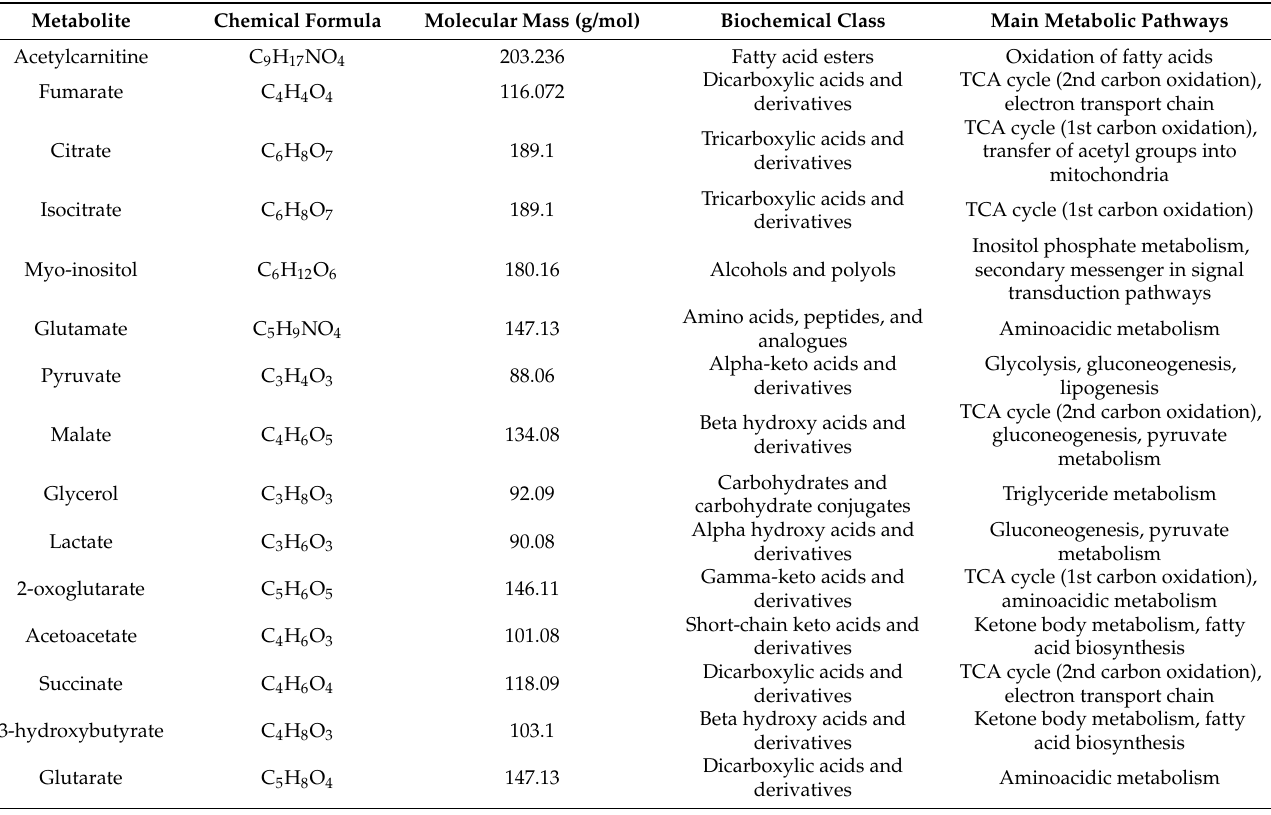
Table 3. Analyzed metabolites and their biochemical